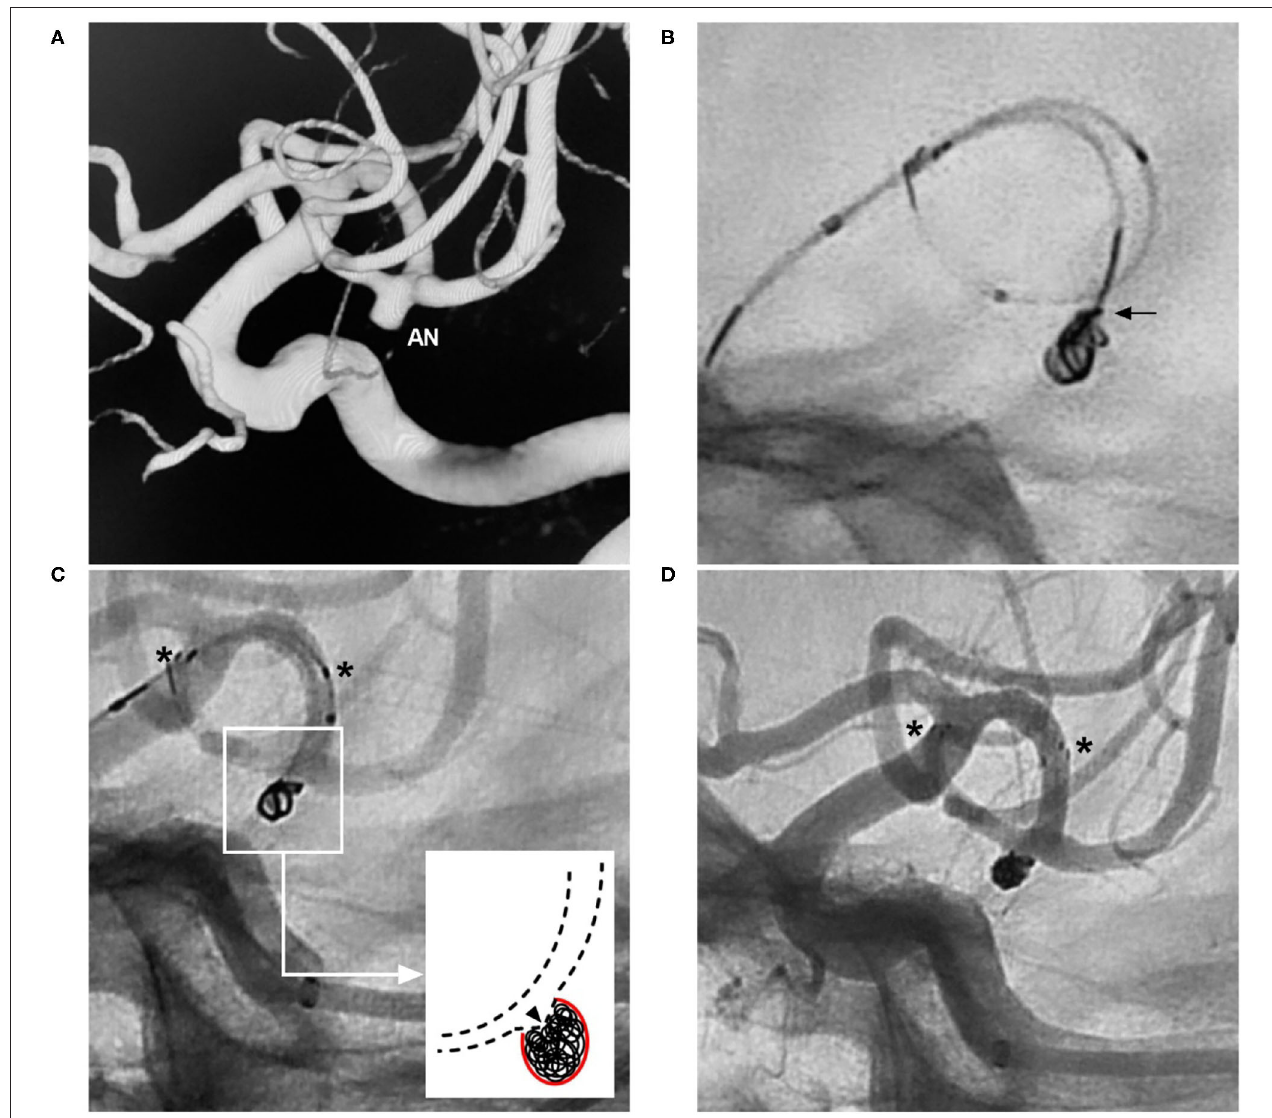
FIGURE 9 | Herniation technique with the NAS. (A) Three-dimensional DSA of the ICA showing an MCA aneurysm (AN). (B) X-ray film showing protrusion of the coil into the parent artery (arrow). (C) Unsubtracted DSA showing that after NAS deployment, the coil was pushed into the aneurysm sac by the herniation technique; the asterisks show the proximal and distal markers of the NAS, and the magnified inset (long arrow from the frame) shows herniation of the struts (triangle) of the NAS into the aneurysm. (D) Postoperative DSA of the ICA showing Raymond-Roy class 1 embolization of the aneurysm; the asterisks show the proximal and distal markers of the NAS. AN, aneurysm; DSA, digital subtraction angiography; ICA, internal carotid artery; MCA, middle cerebral artery; NAS, Neuroform Atlas